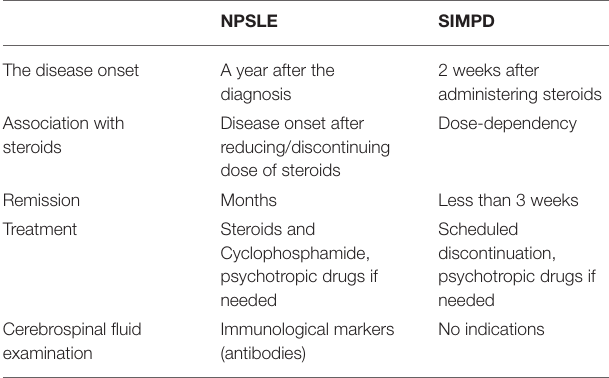
TABLE 3 | The differential diagnosis between the episodes of mania and psychosis in the course of NPSLE and SIMPD.